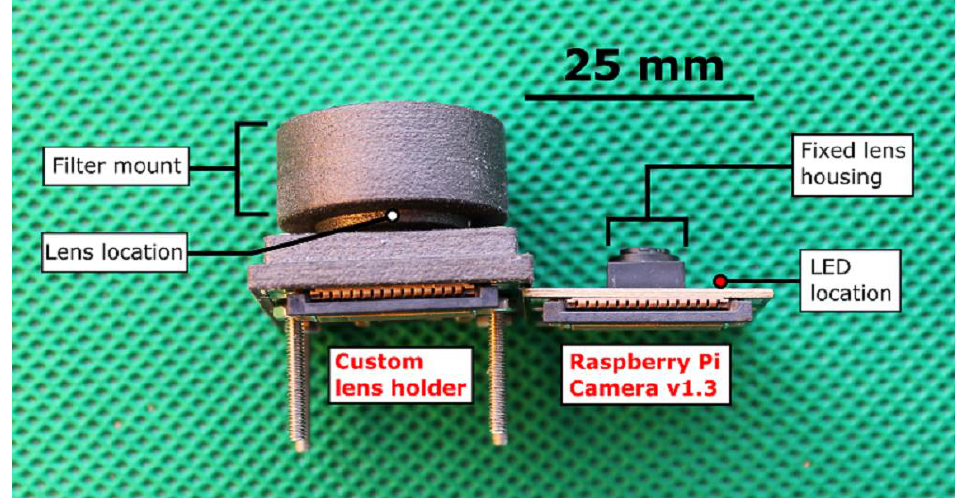
Figure 2. A profile image of the Raspberry Pi Camera Module ( Right ), and the modified system with custom built optics ( Left ). The custom design is bolted to the camera board using the pre-existing mount holes.